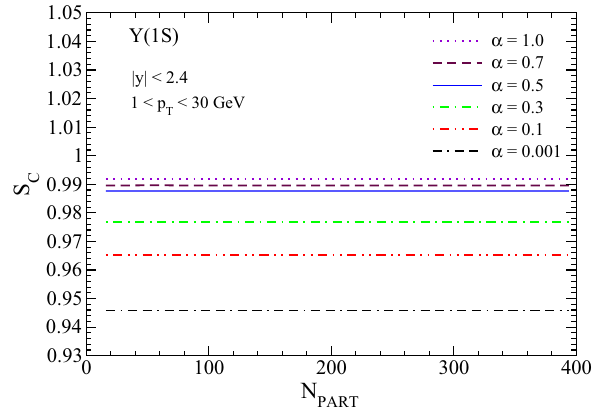
Fig. 3 Correspondingtovariousvaluesofparameter α ,colorscreening survivalprobability( S c )isplottedfor ϒ( 1 S ) asthefunctionofcentrality √ s NN = 2 . 76 TeV LHC energies in Pb–Pb Collisions at + 1. Based on Eq. (15), the allowed values of the azimuthal s angle, φ max ( r ) for survival of bottomonium is expressed as: